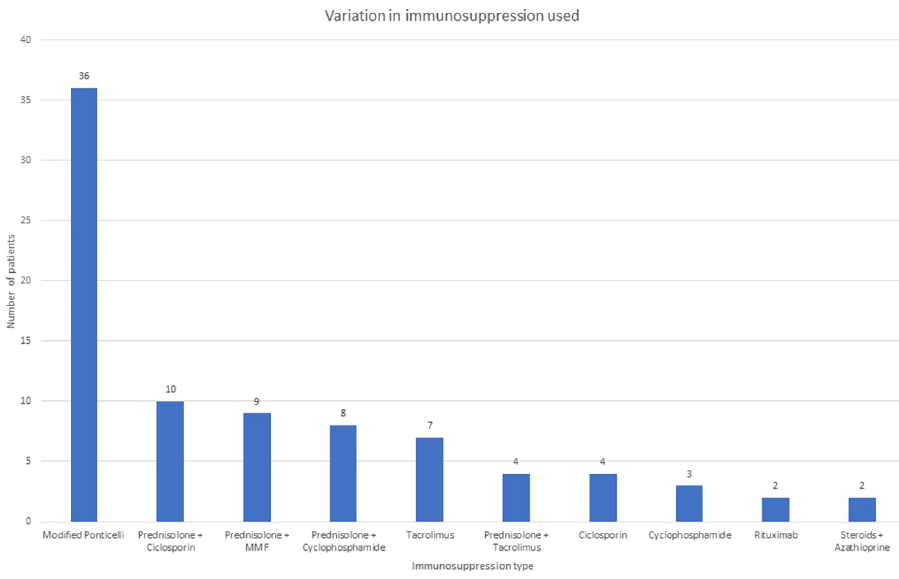
Fig 2. Initial immunosuppression